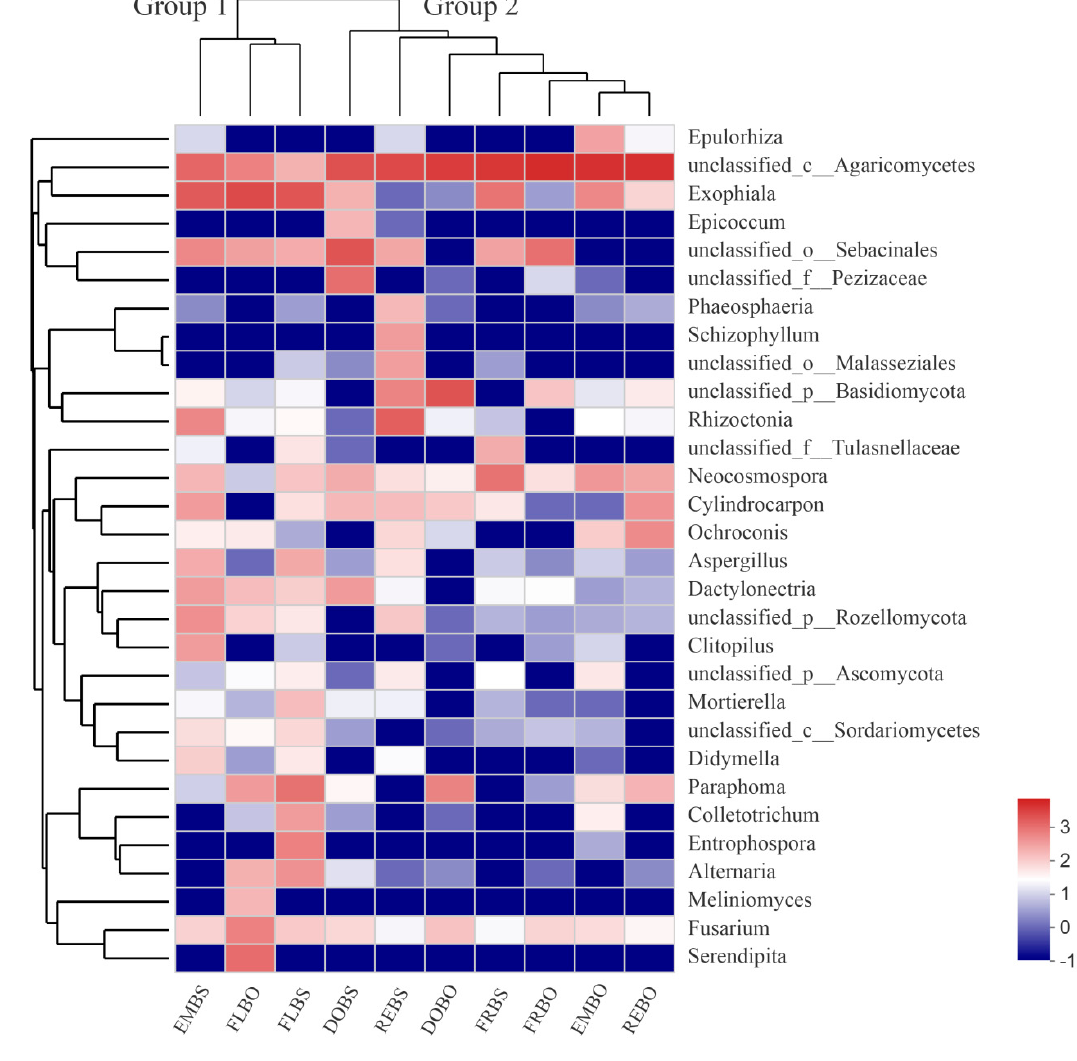
Figure 5. Heatmap of relative abundances of the top 30 fungal genera associated with Bletilla striata and B . ochracea species at different phenological stages. DOBS, B . striata dormancy; FRBS, B . striata fruiting; EMBS, B . striata emergence; REBS, B . striata relaxation; FLBS, B . striata florescence; DOBO, B . striata dormancy; FRBO, B . ochracea fruiting; EMBO, B . ochracea emergence; REBO, B . ochracea relaxation; FLBO, B . ochracea florescence. Rows are fungal genera, and columns are samples. Colors indicate taxa with a higher (red) or lower (blue) relative abundance in each sample.